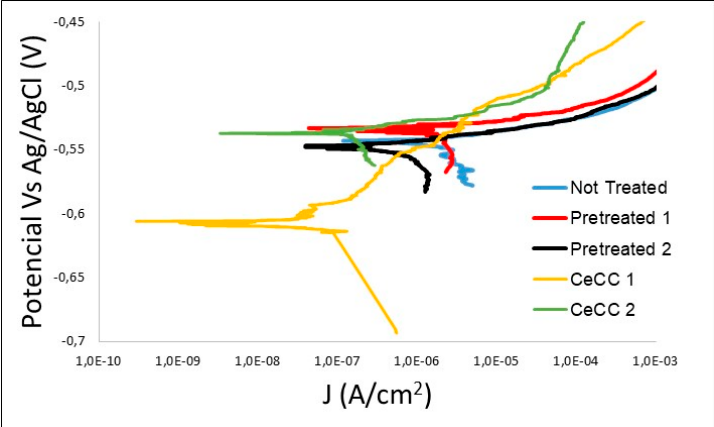
Figure 9. Potentiodynamic linear polarisation ( LP) curves of samples Not Treated, Pretreated 1, Pretreated 2, CeCC-1 and CeCC-2 immersed in NaCl 0.59 M.